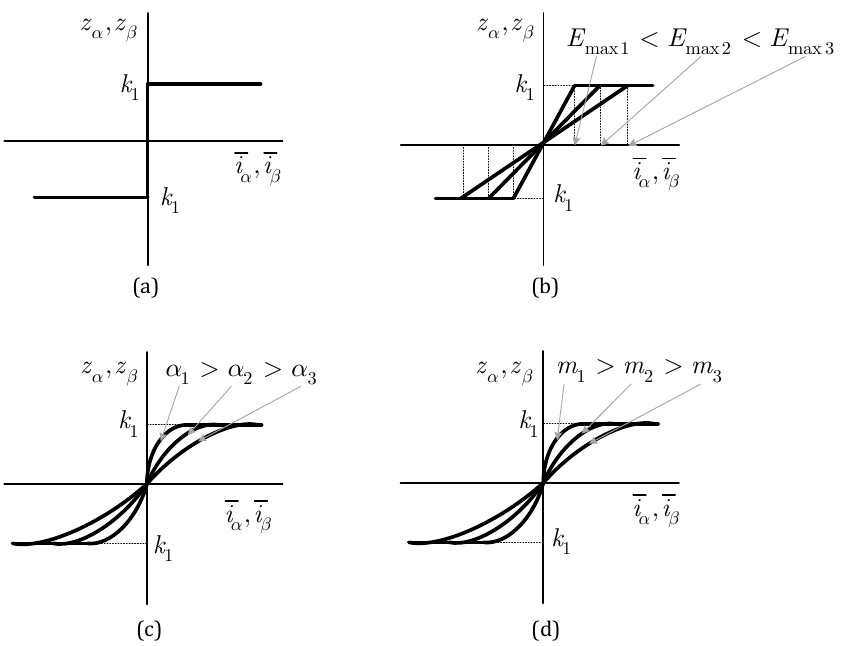
Figure 2. Different types of switching functions: ( a ) signum, ( b ) saturation, ( c ) sigmoid and ( d )